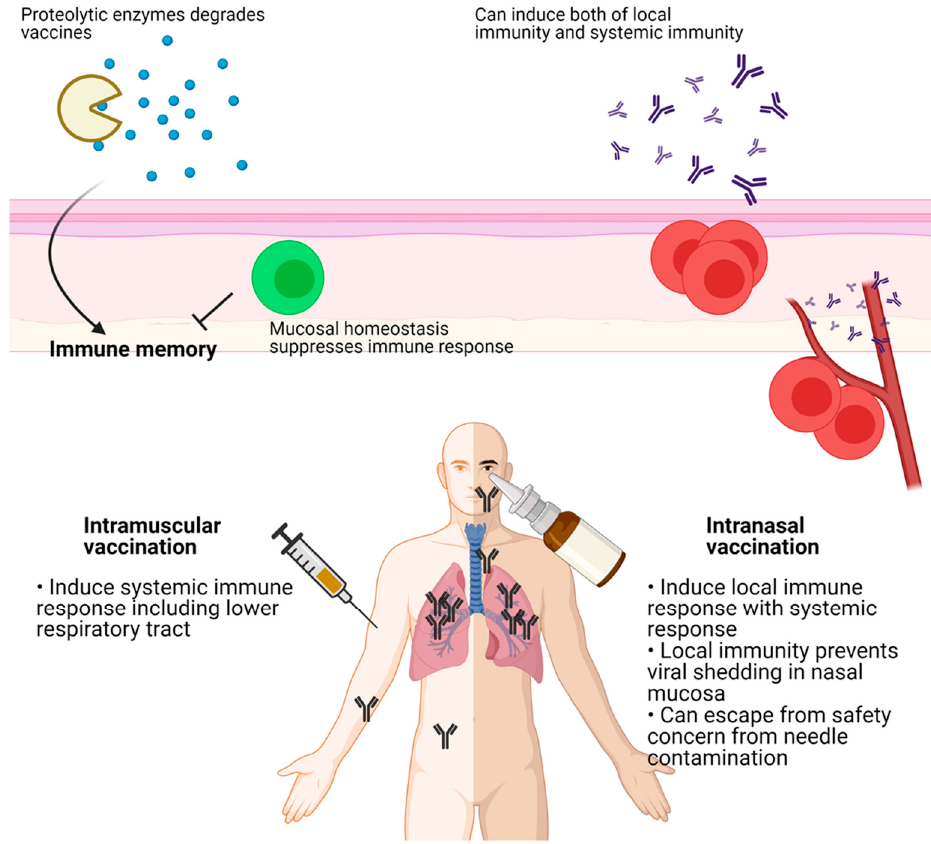
Figure 3. Intramuscular vaccination induces systemic immune response including lower respiratory tract (LRT), but not upper respiratory tract (URT). In contrary, intranasal vaccination induces local immune response in LRT with systemic immunity. Local immunity prevents nasal shedding of viruses which is critical for herd immunity. In the mucosal area, delivered antigens can be degraded by proteolytic enzymes. Mucosal homeostasis inhibits immune response against vaccines. Figure was created by biorender.com (BioRender, Toronto, ON, Canada).